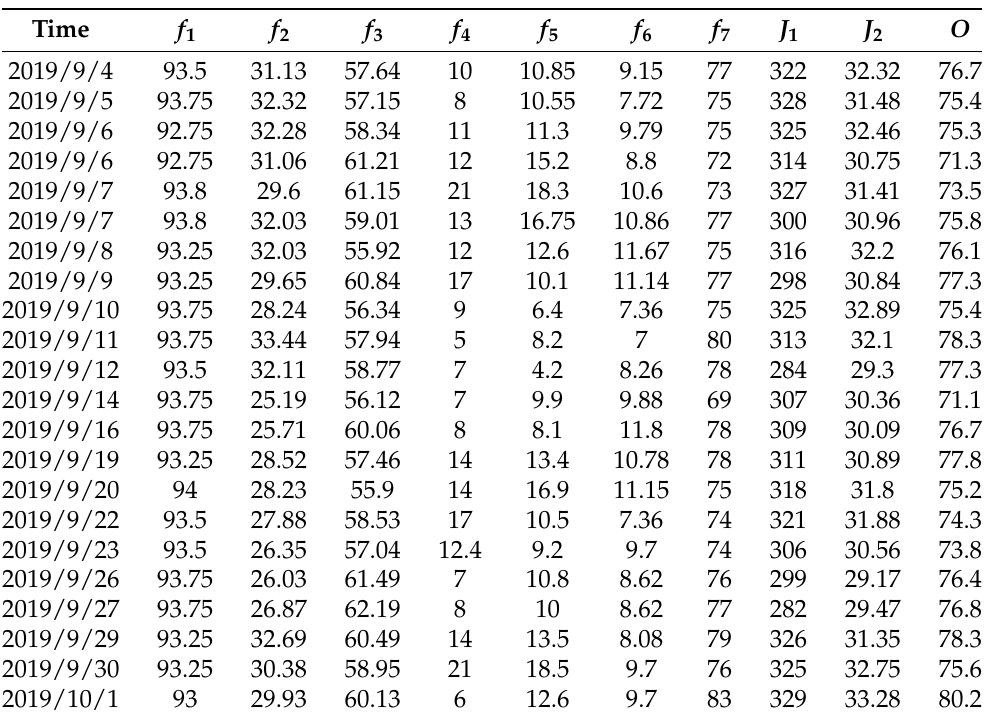
Figure 10. Flowsheet of the optimal-setting system. Table 5. Practical data